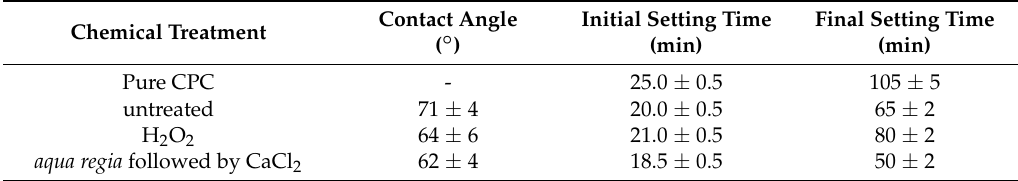
Table 1. Water contact angle of chemically treated fibers and setting kinetics of calcium phosphate cement (CPC)